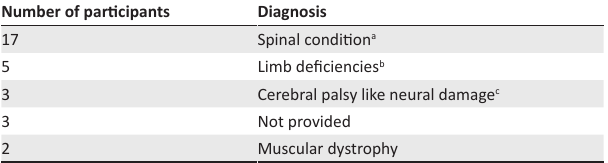
TABLE 1b: Number of participants who were long-term users of a type of wheelchair included in this study, and diagnoses of participants as provided by our partner organisation.